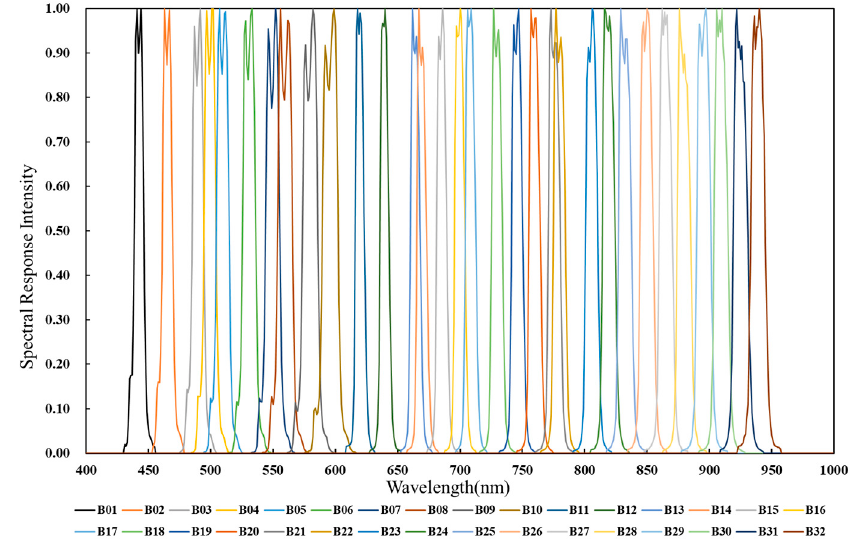
Figure 2. The spectral response function of OHS-F COMS2 sensor.